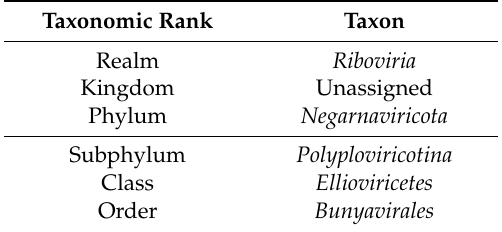
Table 4. Megataxonomic placement of Hantaviridae